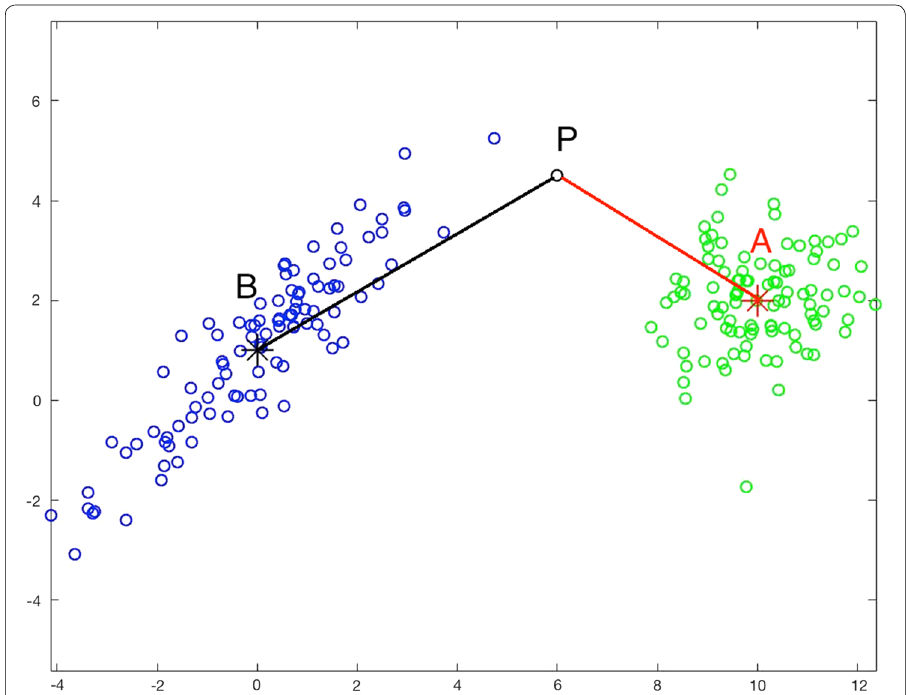
Fig. 1 A typical situation in which the shape of the point clouds must be taken into account for the points assigment: two clusters of gaussian points are represented, both composed by 100 data points. The new data point P is closer to the cluster center A if we use a global metric, like e.g. the Euclidean distance, but the point is more likely to belong to the cluster centered at